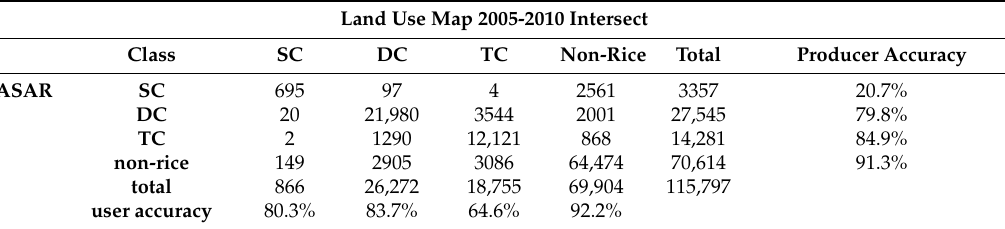
Figure 14. Sampling procedure with a regular 500 m grid from the 2010 land-use map. Table 2. Confusion matrices of the accuracy assessment.